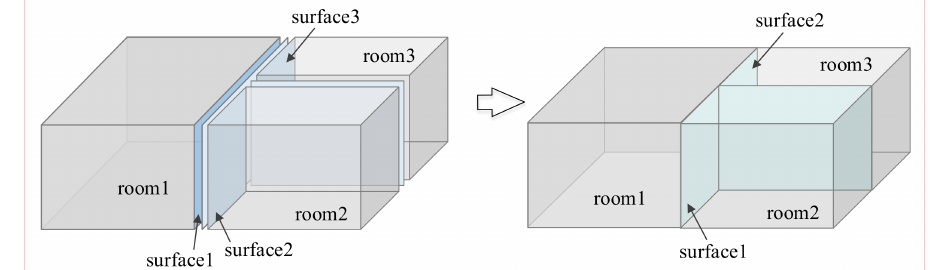
Figure 8. Simplification of walls.